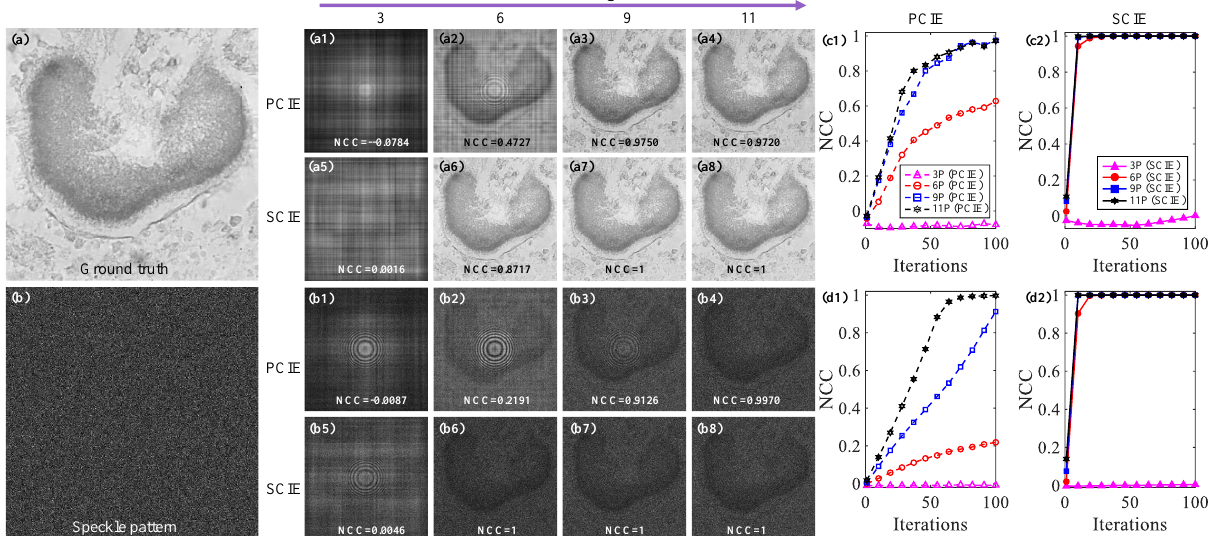
Figure 6. Diffraction and speckle reconstructed results with different numbers of images and NCC curves. ( a ), the ground truth; ( b ), the speckle pattern; ( a1 – a8 ) are reconstructed images obtained by PCIE and SCIE, respectively, by using diffraction patterns, when the number of images is 3, 6, 9 and 11. ( b1 – b8 ) are reconstructed images using speckle patterns in the same case. ( c1 , c2 , d1 , d2 ) are the corresponding NCC curves. Digits represent the number of patterns, P,